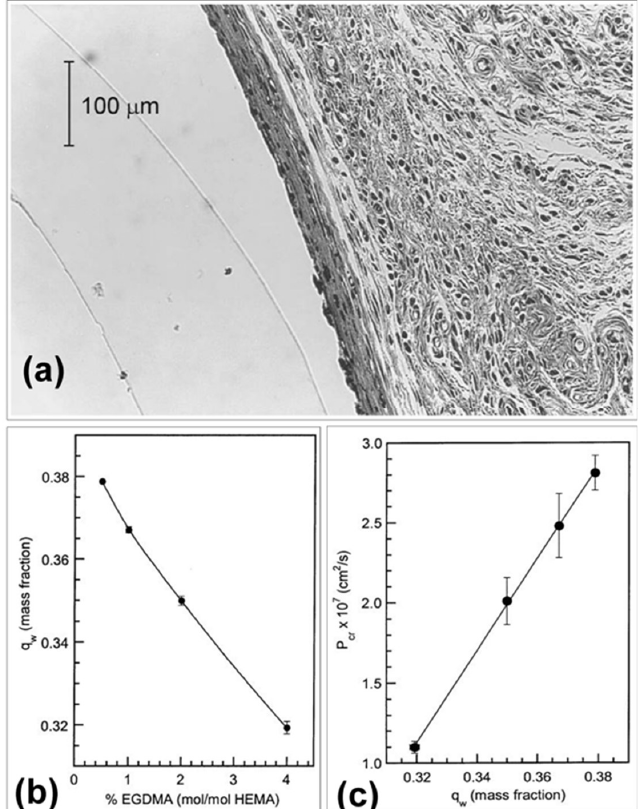
Figure 21. ( a ) Photomicrograph of the host response to a pHEMA membrane implanted for 3 weeks. ( b ) Dependence of equilibrium water content, q w , for flat sheet pHEMA membranes at 37 ◦ C on crosslinking ratio. Experiments were performed in triplicate at each crosslinking ratio. ( c ) Dependence of creatinine permeability at 37 ◦ C in flat sheet pHEMA membranes on equilibrium water content. For reference, the permeability of creatinine in a 1000 MWCO cellulosic dialysis membrane is 9.0 × 10 −7 cm 2 /s [64].